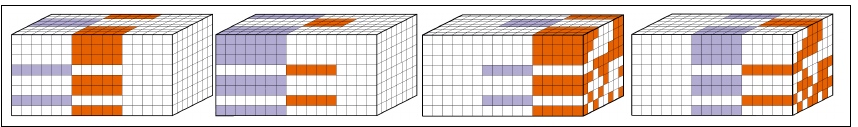
Figure 5. Some variations of prequential evaluation methods. Blocks of data used for training are in lighter lilac, while blocks of data used for testing are in dark